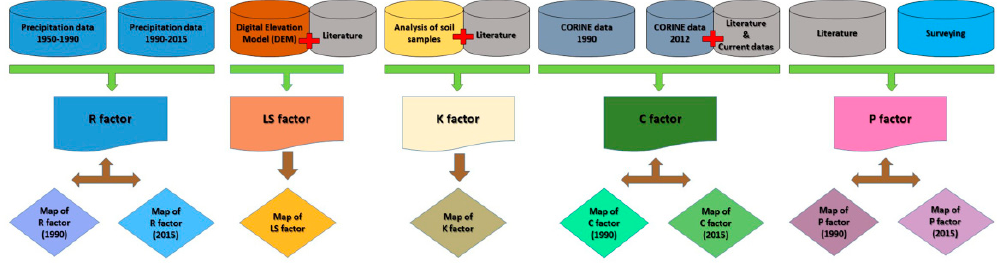
Figure 2. Demonstration of the RUSLE input data.